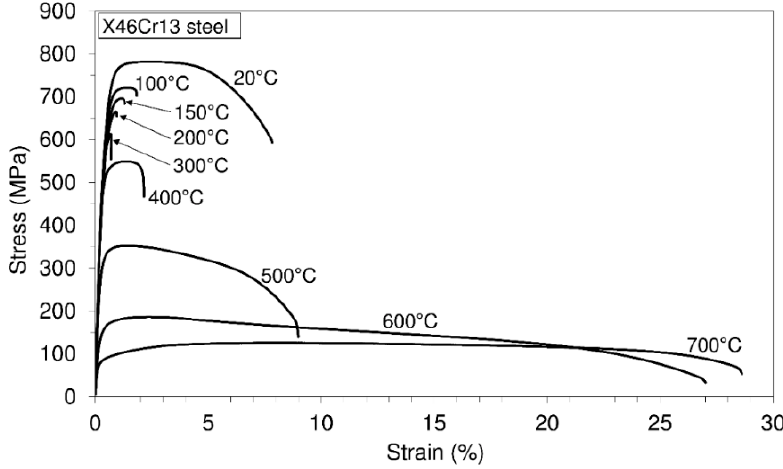
Figure 4. Engineering stress-strain diagrams at different temperatures: X46Cr13 steel.